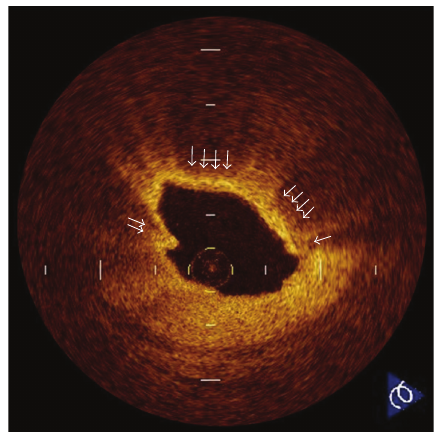
Figure 8: Macrophages . Macrophages (arrows) are seen as signal- rich, distinct, or confluent punctuate regions that exceed the intensity of background speckle noise. The high contrast and resolution of OCT enable the quantification of macrophages within fibrous caps of atherosclerotic